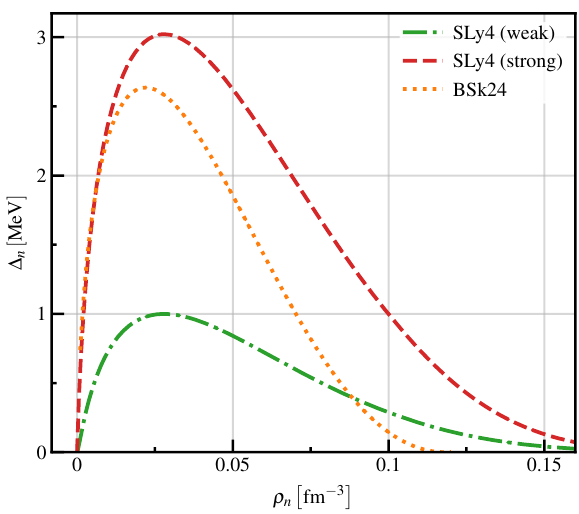
Figure 3. The pairing gap in pure neutron matter (PNM), as a function of density, for the two pairing strengths used with the SLy4 functional (green dash-dotted line shows weak, red dashed line shows strong), and for the BSk24 functional (orange dotted line). See text for